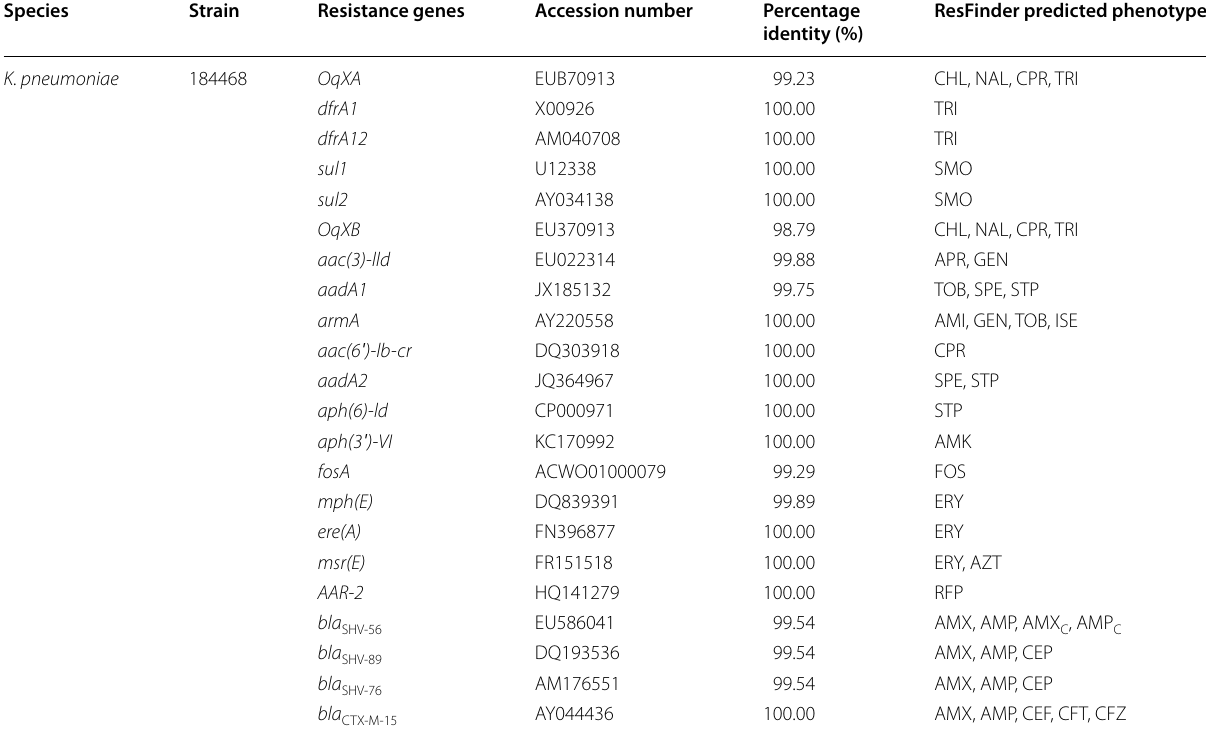
Table 5 ResFinder results for resistance genes of Klebsiella pneumoniae